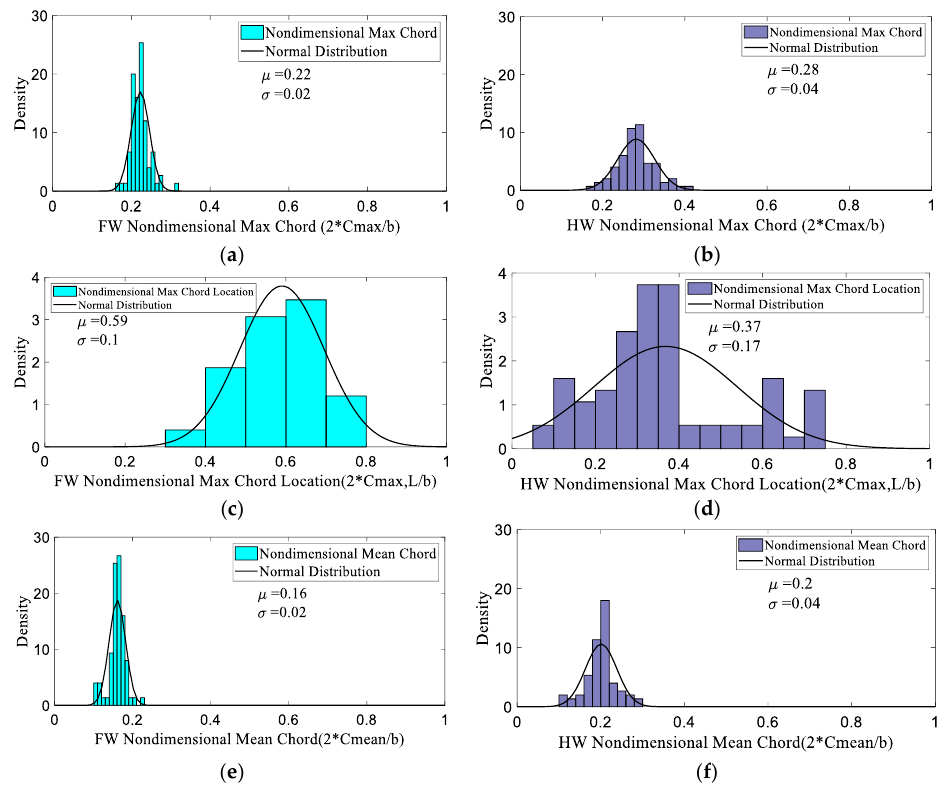
Figure 6. Probability density function ( PDF) and fitted normal distribution of forewing (FW) max chord ( a ), hindwing (HW) max chord ( b ), FW max chord location ( c ), HW max chord location ( d ), and FW mean chord ( e ) and FW mean chord ( f ).